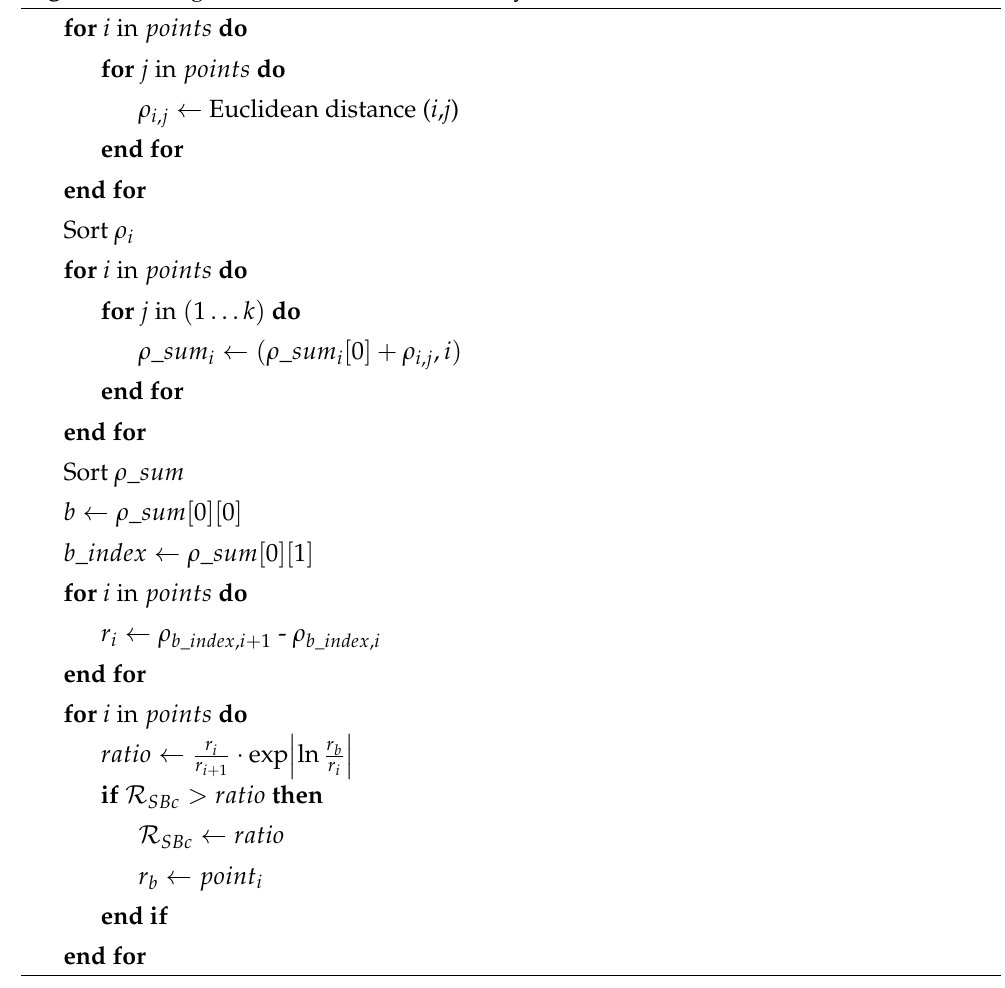
Algorithm 2 Algorithm for the stabilized barycenter-based